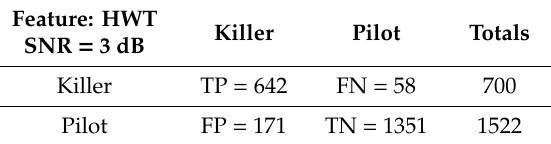
Table 5. Classification results: HWT, SNR = 3 dB.